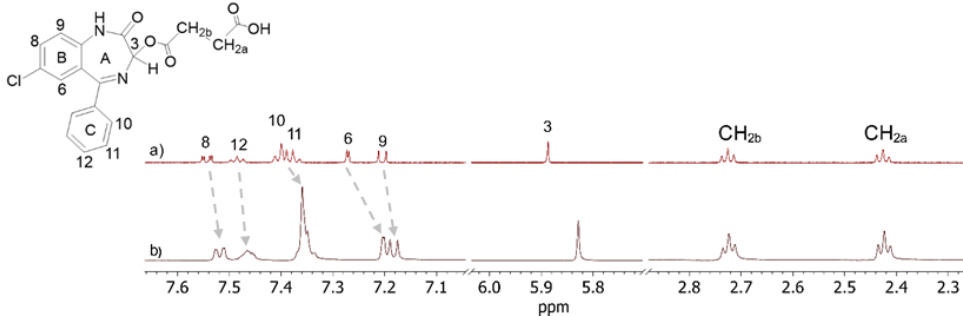
Figure 2. 1 H NMR (600 MHz, K 2 HPO 4 /D 2 O 50 mM, 25 °C) spectra of OXEMIS: ( a ) 1 mM and ( b ) 12 mM.